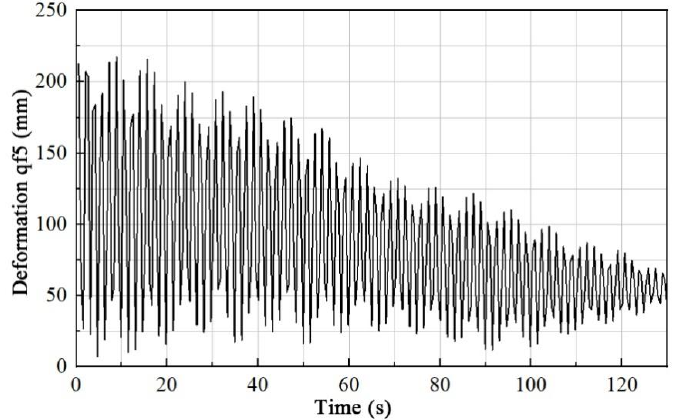
Figure 5. Lateral 1/4 Circumferential Deformation of the Top Node.